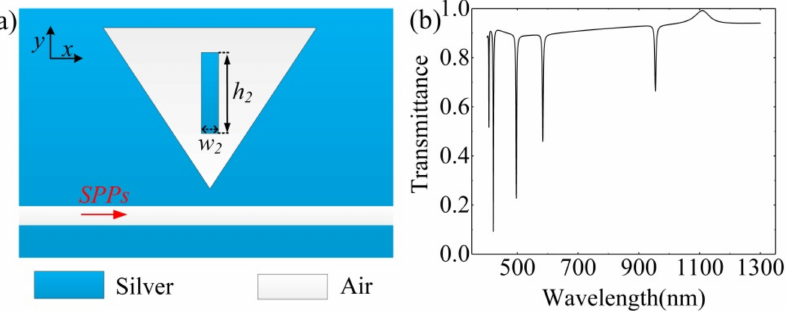
Figure 7. ( a ) The schematic of the inverted ETSC added with a bar; ( b ) the transmittance spectrum of the inverted ETSC with a